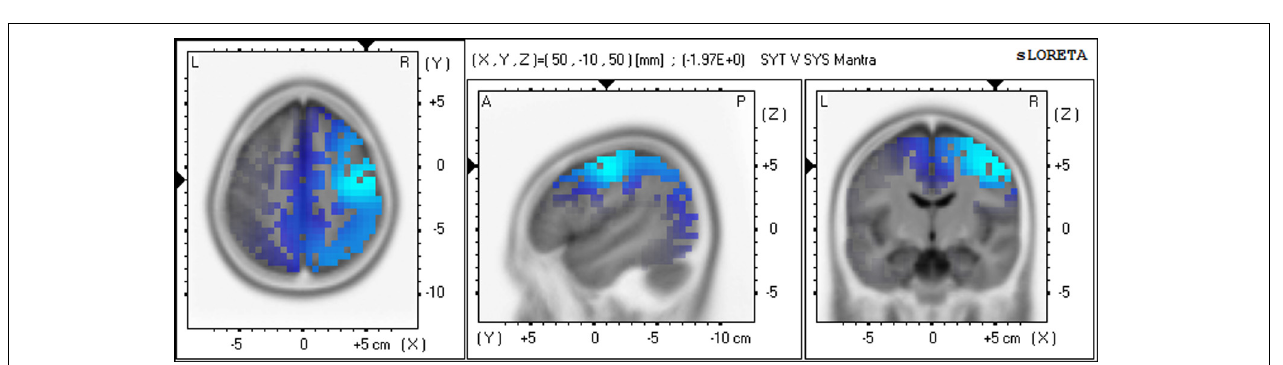
FIGURE 3 | Differences in CSD between groups in alpha1 band—Meditation 2 (Mantra) Increased alpha1 activity (blue) in SYS compared to SYT in right BA4 (precentral gyrus).